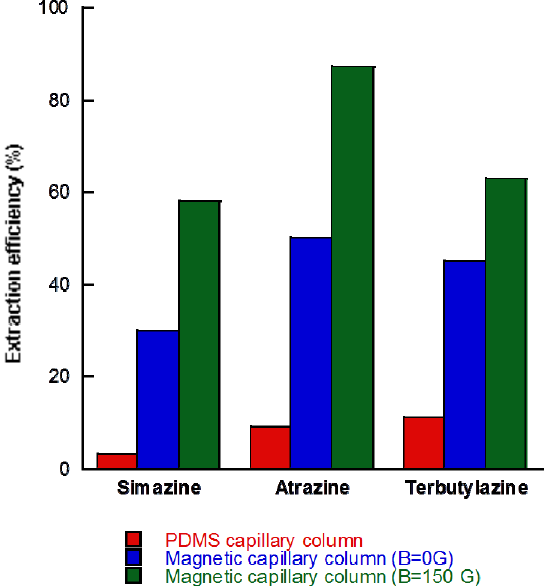
supported Fe O capillary column 2 3 4